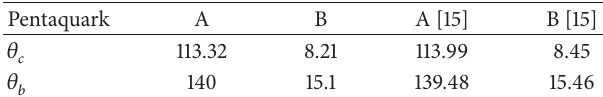
Table 4: Pentaquark calculated masses (MeV) for 𝐼 = 0